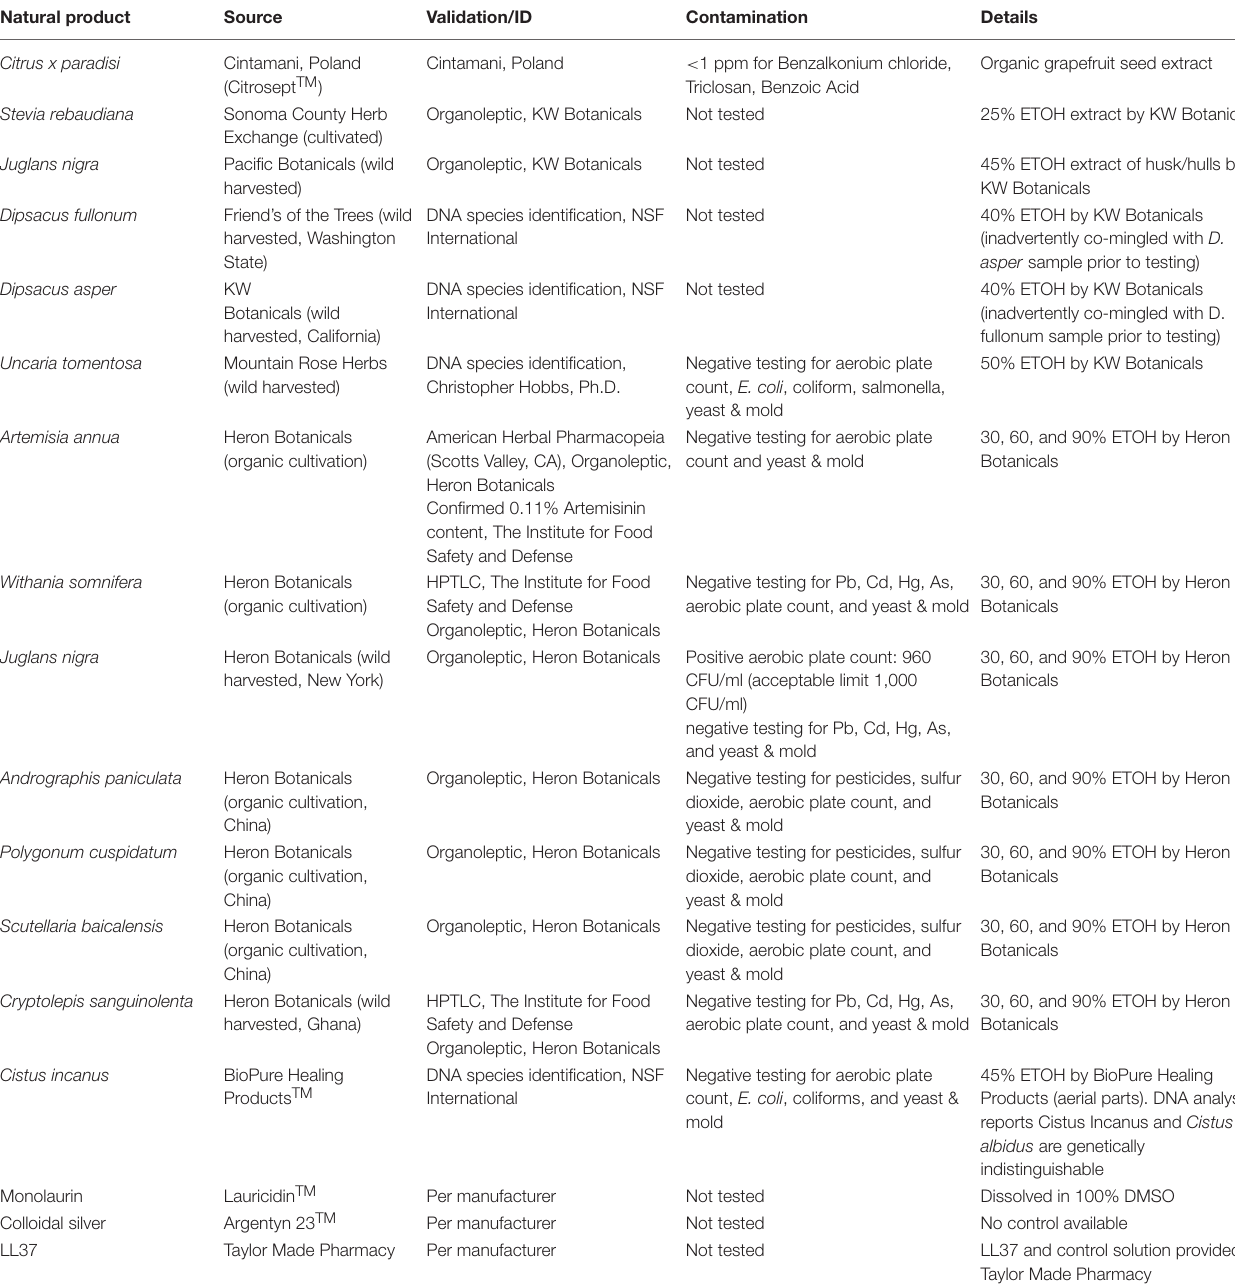
TABLE 1 | Botanical and natural medicine sources, validation, and